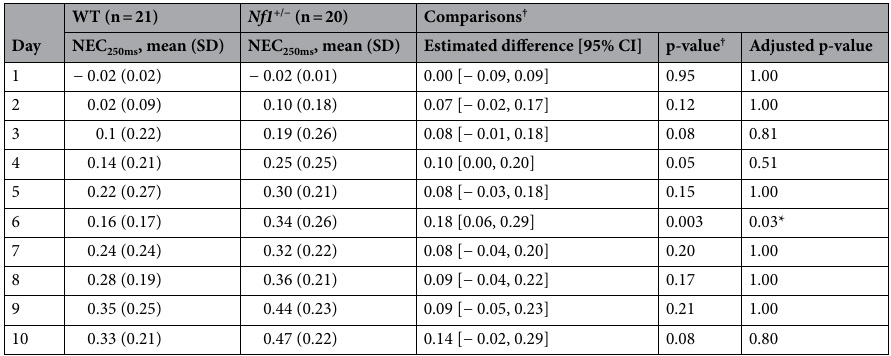
Table 1. Normalized eye closure at 250 ms after CS onset for the 250 ISI training phase. *Significant difference between genotypes of p < 0.05. † The degrees of freedom for all comparisons is 39. WT wild type .